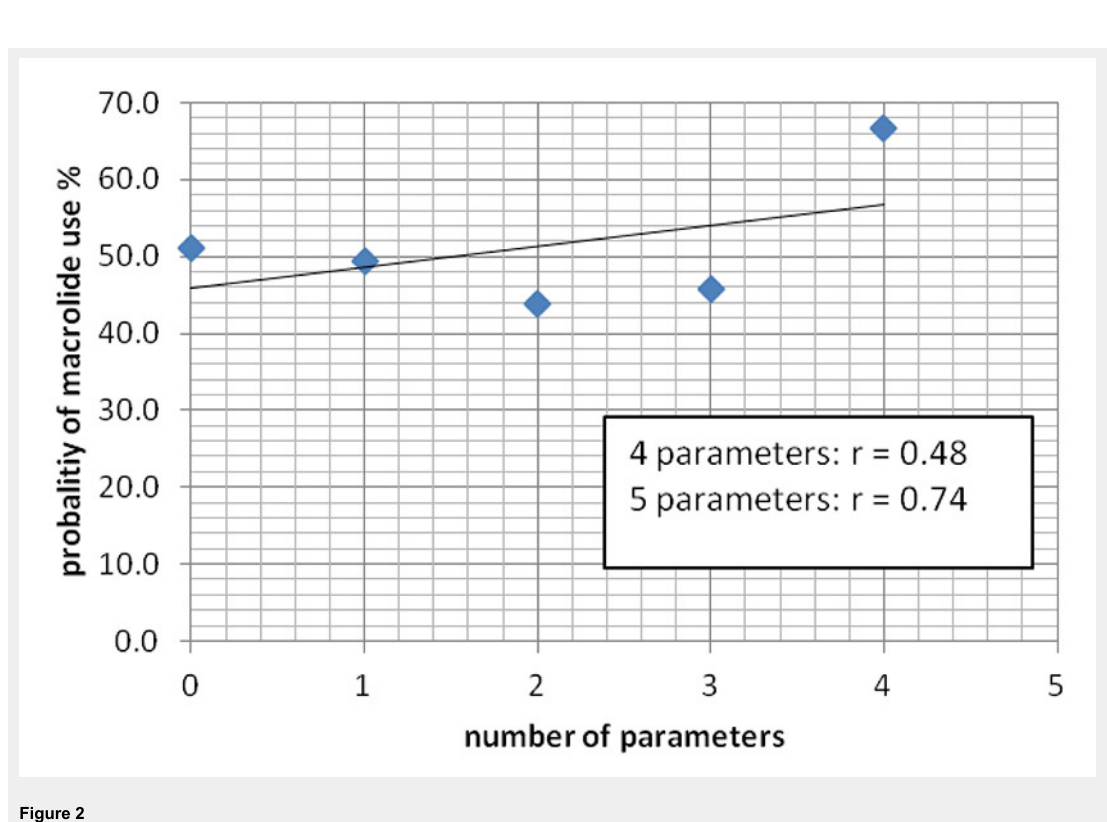
Correlation between the number of parameters investigated and the probability of macrolide